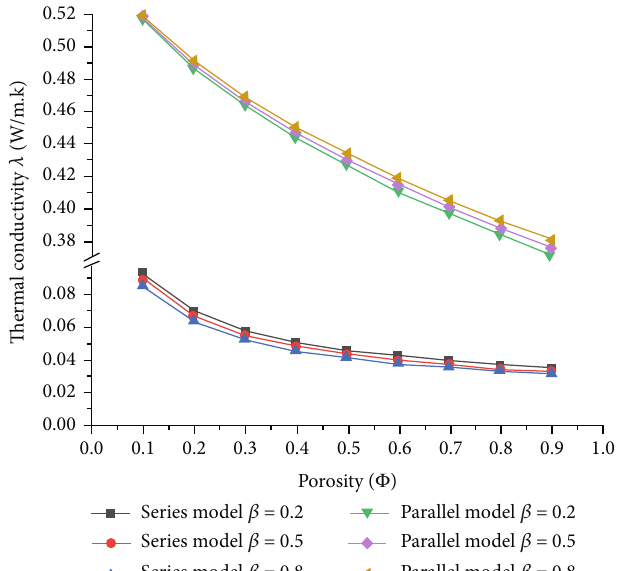
Figure 12: Relationship between thermal conductivity λ and porosity φ of simpli fi ed volume-weighted average REV model with di ff erent water ratio β